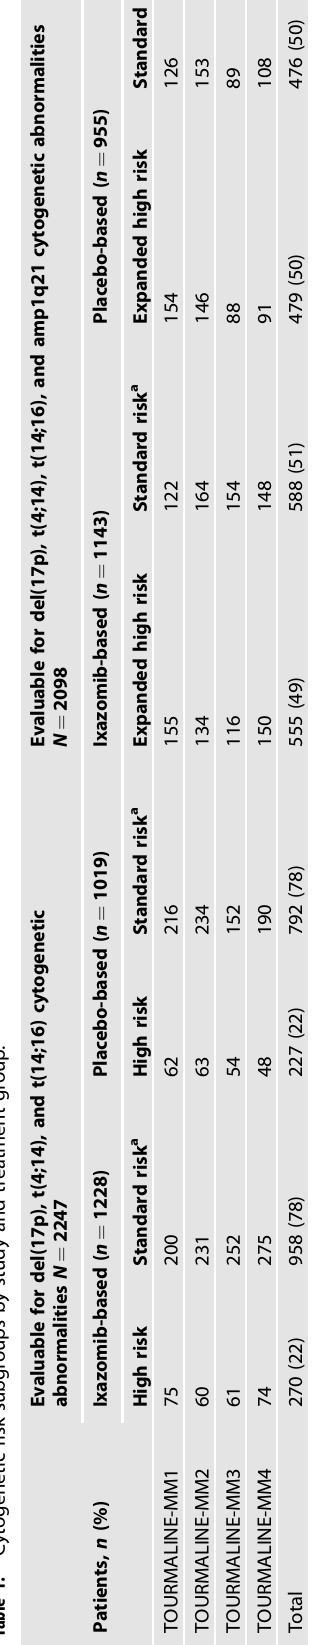
p = 0.0001; median PFS 26.3 vs 17.6 months) (Figs. 1 and 2B). The HR for PFS with ixazomib- vs placebo-based therapy in the expanded high-risk subgroup was 0.75 (95% CI: 0.64 – 0.87; p = 0.0002). The median PFS was 18.1 months for patients receiving ixazomib-based therapy compared with 14.1 months for patients receiving the placebo-based regimen (Figs. 1 and 3A). For patients in the expanded high-risk complementary standard- risk subgroup, the HR for PFS with ixazomib- vs placebo-based therapy was 0.71 (95% CI: 0.59 – 0.85; p = 0.0002; median PFS 36.1 vs 21.4 months) (Figs. 1 and 3B). When cytogenetic risk status was compared in patients receiving ixazomib-based therapy, median PFS for patients in the high-risk subgroup was 17.8 months, vs 26.3 months in the standard-risk subgroup (complement of high-risk) (HR: 0.65; 95% CI: 0.54 – 0.78; Supplementary Fig. 1A). For patients in the expanded high-risk subgroup, median PFS was 18.1 months, vs 36.1 months in the standard-risk subgroup (complement of expanded high-risk) (HR: 0.54; 95% CI: 0.46 – 0.64; Supplemen- tary Fig. 1B). PFS analysis according to the presence of individual cytogenetic abnormalities In patients with t(4;14), the HR for PFS with ixazomib- vs placebo- based therapy was 0.68 (95% CI: 0.48 – 0.96; p = 0.0268; median 22.4 vs 13.2 months) (Figs. 1 and 4A). For patients with amp1q21, the HR for PFS with ixazomib- vs placebo-based therapy was 0.77 (95% CI: 0.63 – 0.93; p = 0.0071; median 18.8 vs 14.5 months) (Figs. 1 and 4B). For patients with del(17p), the HR for PFS with ixazomib- vs placebo-based therapy was 0.80 (95% CI: 0.59 – 1.09; p = 0.1651; median 15.7 vs 13.2 months) (Figs. 1 and 4C). To assess the impact of del(17p) on outcomes independent of treatment, we analyzed PFS according to the presence of del(17p) vs standard- risk cytogenetics in patients who received placebo-based therapy (Supplementary Fig. 2). The HR for PFS for patients with del(17p) vs standard-risk cytogenetics was 0.69 (95% CI: 0.54 – 0.88; p = 0.0023; median 17.6 vs 13.2 months). For the analysis in patients with t(14;16) there were only 11 events in 16 patients receiving ixazomib-based therapy and 14 events in 23 patients receiving placebo-based therapy; the median PFS was 11.4 and 15.9 months, respectively (HR 1.21; 95% CI: 0.55 – 2.69; p = 0.634) (Supplementary Fig. 3). Sensitivity analysis of PFS strati fi ed by study A sensitivity analysis of PFS was performed; the HRs with ixazomib- vs placebo-based therapy were 0.71 (95% CI: 0.57 – 0.89; p = 0.0033) for patients with high-risk cytogenetic abnormalities and 0.68 (95% CI: 0.59 – 0.77; p = 0.0001) for patients in the complementary standard-risk subgroups. Similarly, the HRs for PFS with ixazomib- vs placebo-based therapy were 0.70 (95% CI: 0.60 – 0.82; p = 0.0001) for patients in the expanded high-risk subgroup, and 0.67 (95% CI: 0.55 – 0.80; p = 0.0001) for patients in the respective standard-risk subgroup (Fig. 5). In patients with del(17p), t(4;14), and amp1q21, the HRs for PFS with ixazomib- vs placebo-based therapy were 0.75, 0.67, and 0.72 (Fig. 5). PFS analysis by combination (non-maintenance) vs single- agent (maintenance) therapy Analyses of PFS to investigate whether ixazomib in combination with Rd (TOURMALINE-MM1 and TOURMALINE-MM2) improves outcomes for patients with high-risk cytogenetic abnormalities vs single-agent ixazomib (TOURMALINE-MM3 and TOURMALINE- MM4) are shown in Fig. 6. In patients with high-risk cytogenetic abnormalities, the HR for PFS with ixazomib- vs placebo-based therapy in TOURMALINE- MM1 and TOURMALINE-MM2 (combination non-maintenance) was 0.64 (95% CI: 0.46 – 0.89; p = 0.007). In TOURMALINE-MM3 T a